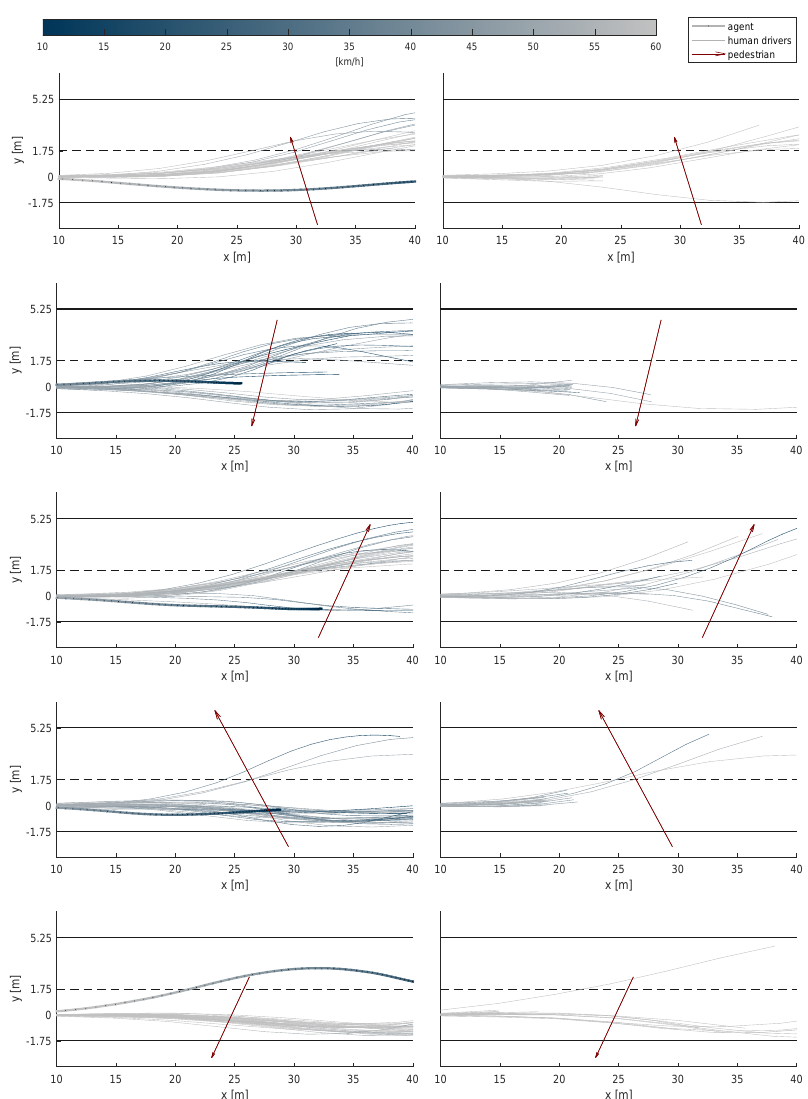
Figure 9. Routes of successful ( left ) and unsuccessful ( right ) completions of Scenarios 10, 7, 2, 3, and 6. The path of the agent is marked with a thick